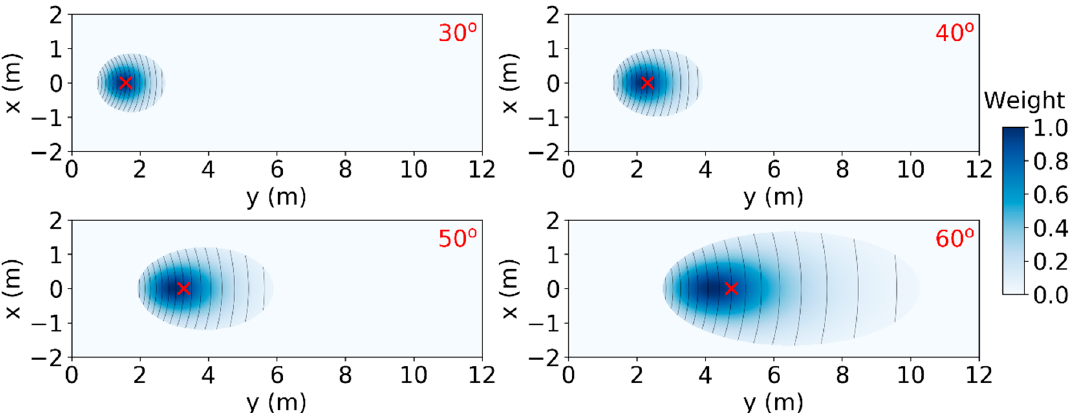
Figure 5. Weight relative to maximum diagram where X and Y are coordinates (in meters) on the field from the radiometer (0, 0). Red crosses are the incidence angles of the antenna footprint center. Grey lines for incidence angles inside the footprint by 2° step.